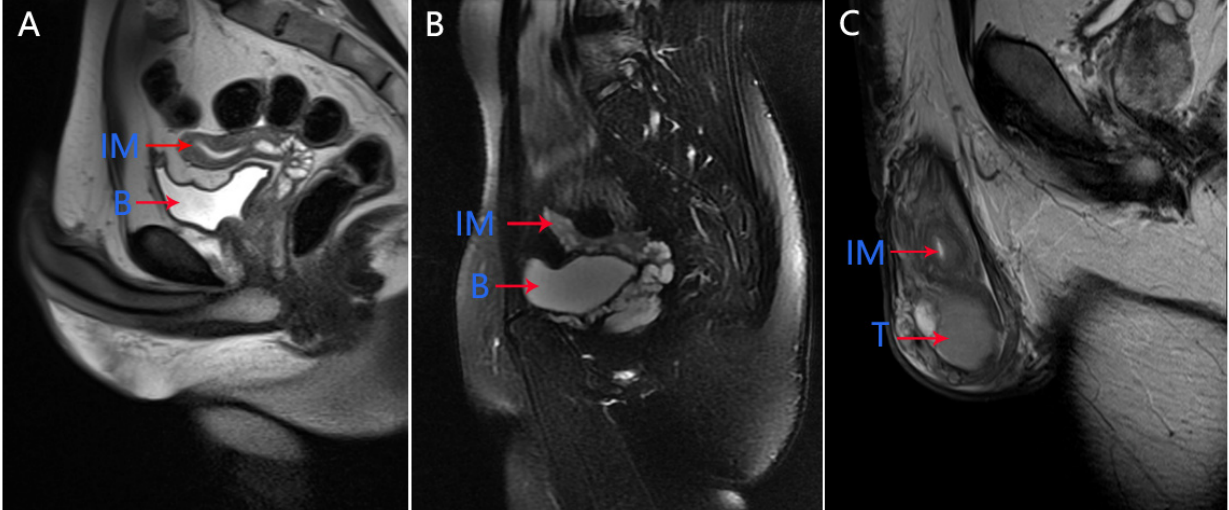
Figure 1. Pelvic magnetic resonance images of the three cases. Pelvic magnetic resonance images show Müllerian remnants in cases 1 ( A ), 2 ( B ), and 3 ( C ). IM, immature uterus; B, bladder; T, testis.